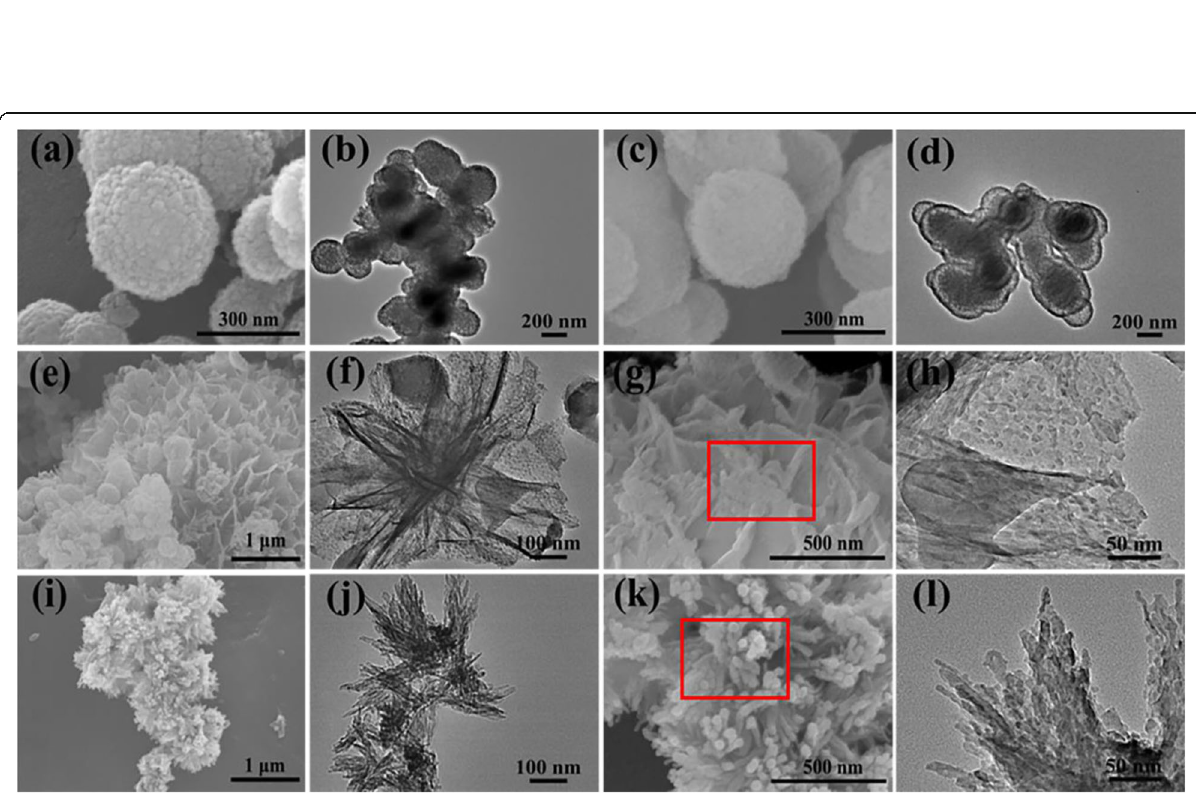
Fig. 4 SEM and TEM images of ATP-CG microspheres synthesized with Ca/P = 3.3 under different experimental conditions. a , b T = 120 °C, t = 5 min. c , d T = 120 °C, t = 15 min. e – h T = 120 °C, t = 60 min. i – l T = 160 °C, t = 15